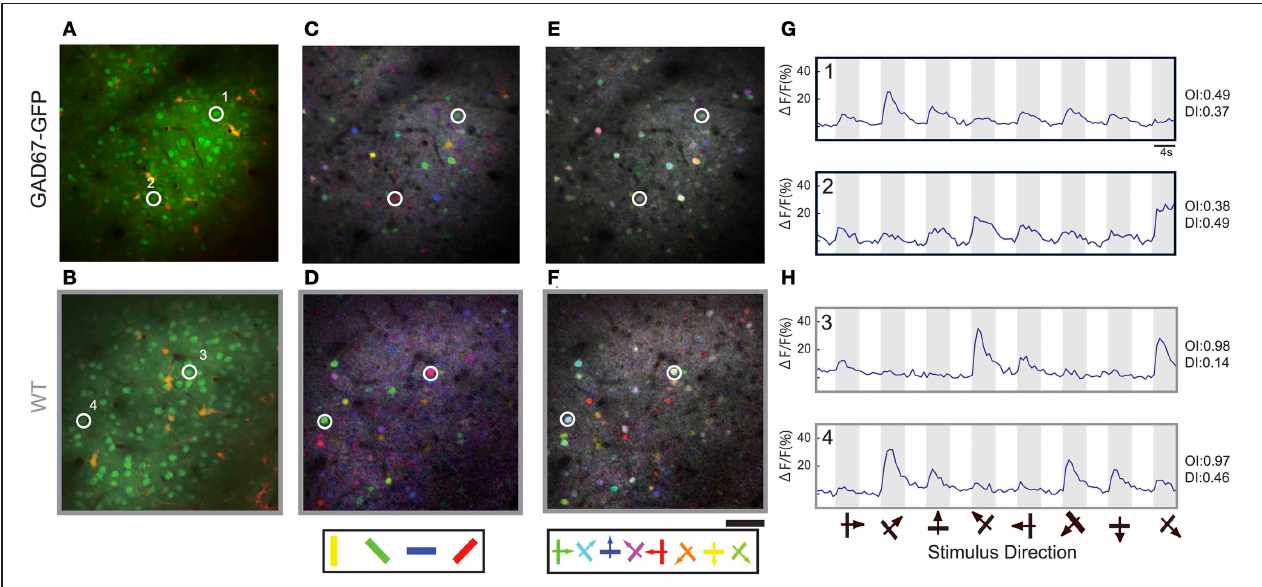
FIGURE 1 | In vivo two-photon Ca 2 + imaging of orientation selectivity and direction selectivity in GAD67-GFP and WT mice. (A,B) Optical sections of GAD67-GFP (A) and WT (B) mice at the level of layer 2/3 (about 200 μ m depth) in primary visual cortex stained with OGB-1 AM (green) and astrocyte marker Sulfarhodamine 101 (red). (C,D) Pixel-based orientation maps of GAD67-GFP (C) and WT (D) mice, coding for preferred orientation (hue), response amplitude (lightness), and tuning width (saturation).